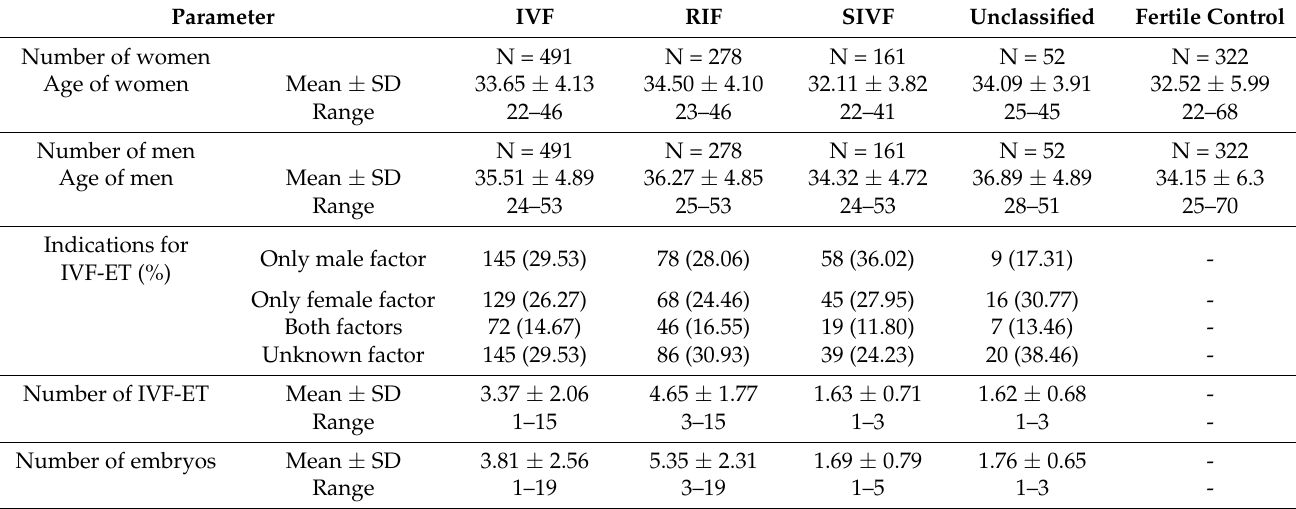
Table 2. Clinical characteristics of patients and fertile